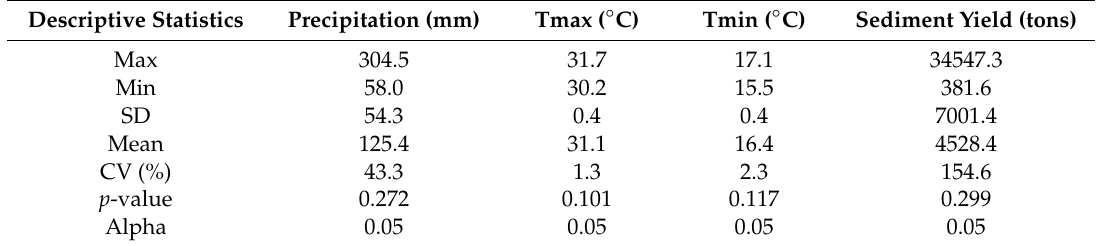
Figure 5. Historical trends of the annual precipitation ( a ), temperature maximum (Tmax) ( b ), temperature minimum (Tmin) ( c ), and sediment yield ( d ) from 1971–2000 in the Logiya watershed. Table 2. Statistical summary of annual baseline data (1971–2000).